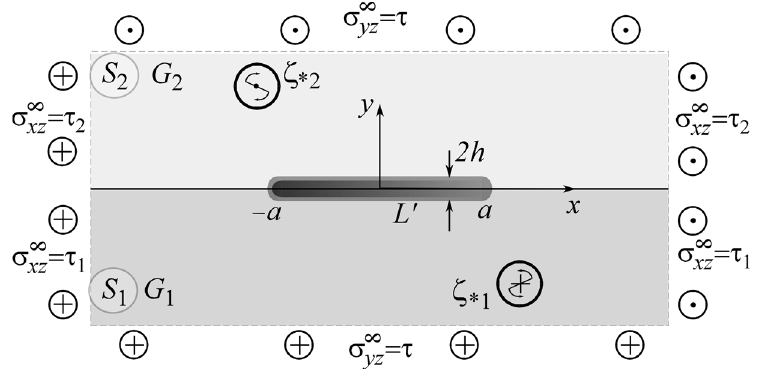
Figure 1. The loading and geometric scheme of the problem. According to the paradigm of the method of jump functions [36], the presence of a thin inclusion in the bulk is modeled by jumps in the components of stress and displace ‐ ment vectors in [38,40,41]: